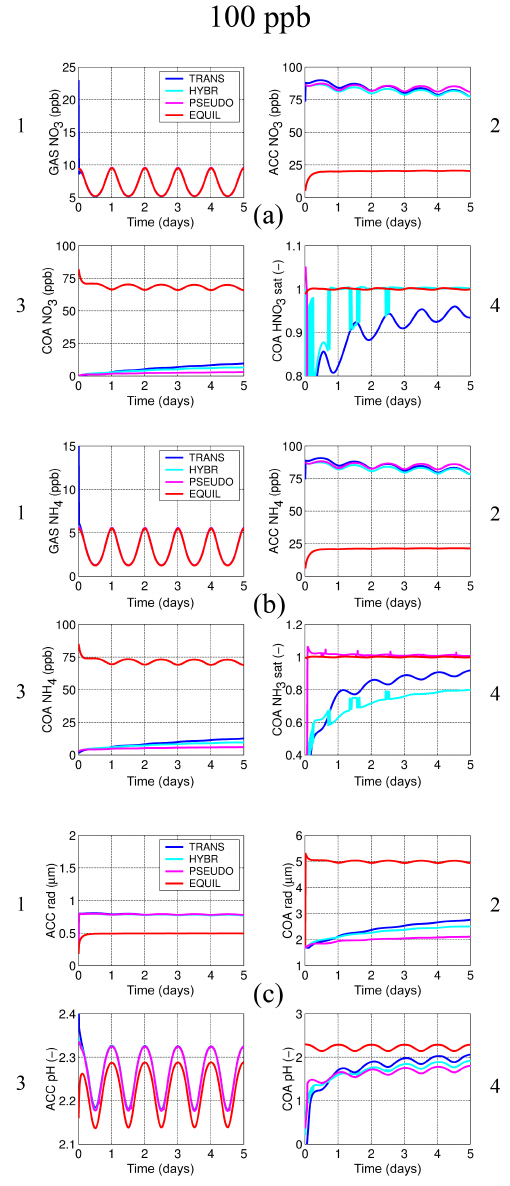
Figure 8. Same as Fig. 5 with initial mixing ratios of HNO 3 (g) and NH 3 (g) of 100ppb, and the gas phase (a.1, b.1) shown instead of the Aitken mode, respectively. In panel (c.3) , TRANS, HYBR, and PSEUDO produce largely similar